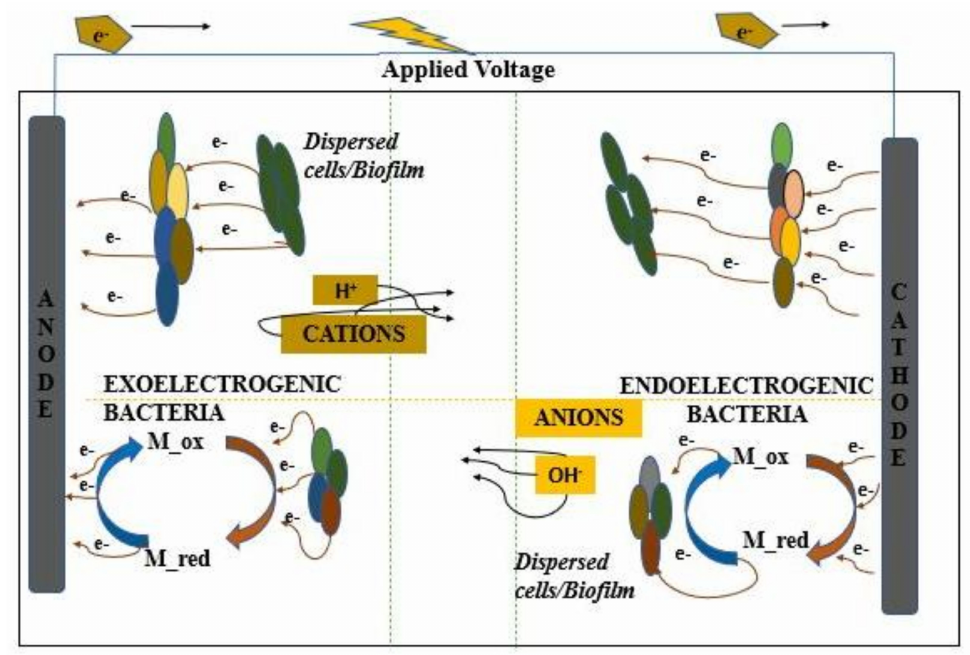
Figure 3. A diagram representing the principles of electro-fermentation, Adapted from ref.